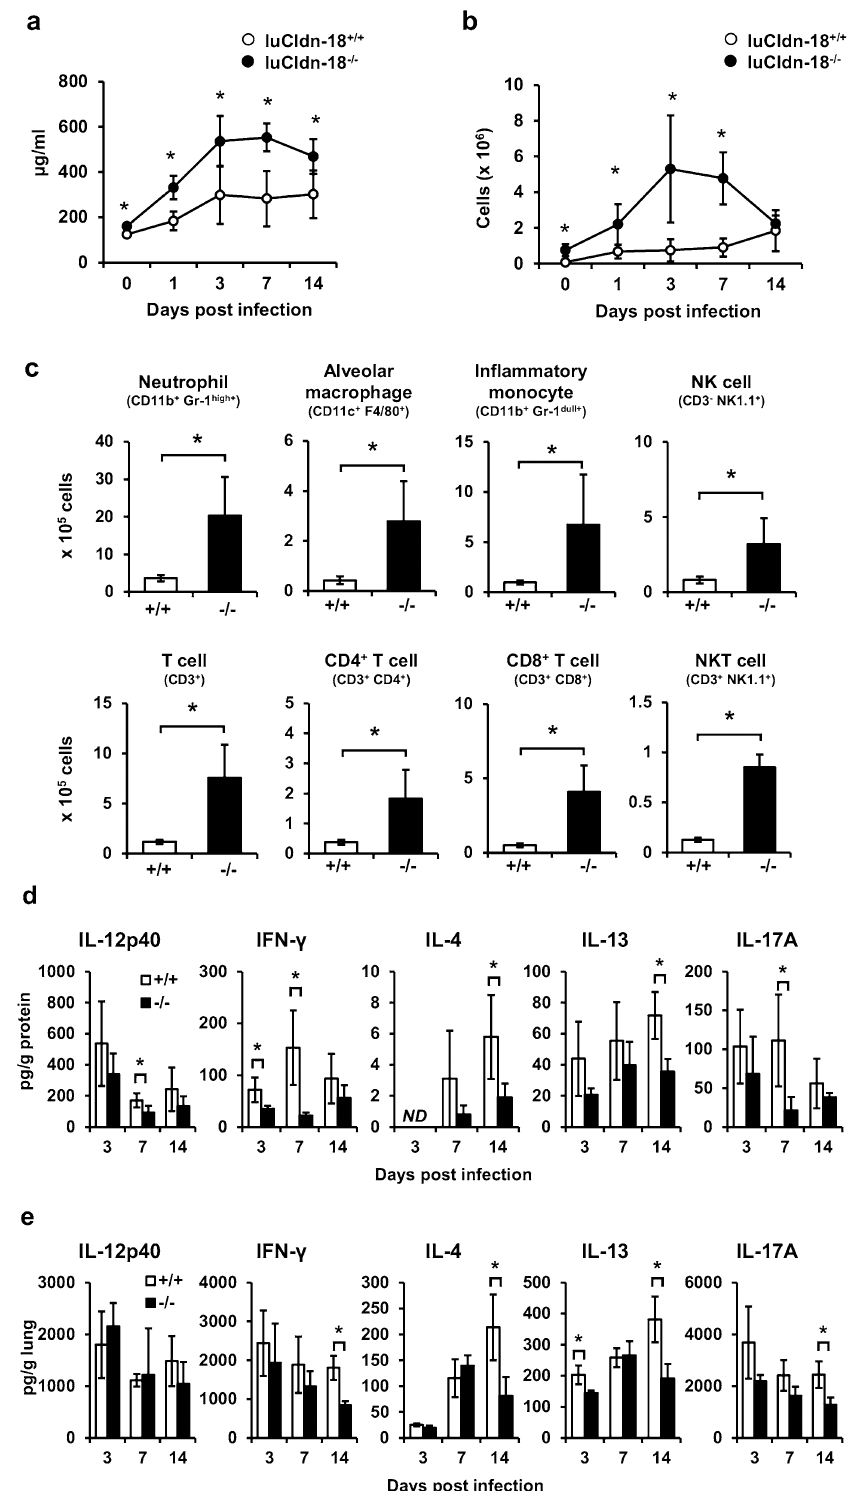
Figure 4. Effects of luCldn-18 deficiency on inflammatory response in BALFs after infection with C. deneoformans. luCldn-18 +/+ (day 0, n = 4; day 1, n = 5; day 3, n = 5; day 7, n = 6; day 14, n = 6) and luCldn-18 −/− mice (day 0, n = 4 ;day 1, n = 4; day 3, n = 6; day 7, n = 6; day 14, n = 7) were infected intratracheally with C. deneoformans. Protein concentration ( a ) and cell counts ( b ) in BALFs were measured on days 0 (uninfected), 1, 3, 7, and 14 post-infection. Each column represents the mean ± SD. ( c ) BALF cells were prepared on day 3 post-infection. The cell population was analyzed using flow cytometry, and the number in each subset was calculated. Each column represents the mean ± SD. Cytokine production in BALF ( d ) and lung interstitial homogenates after BAL ( e ) at the indicated time intervals after C. deneoformans infection. Each column represents the mean ± SD. +/+, luCldn-18 +/+ mice. −/−, luCldn-18 −/− mice. ND , not detected. *, p < 0.05. There were no mice excluded from this